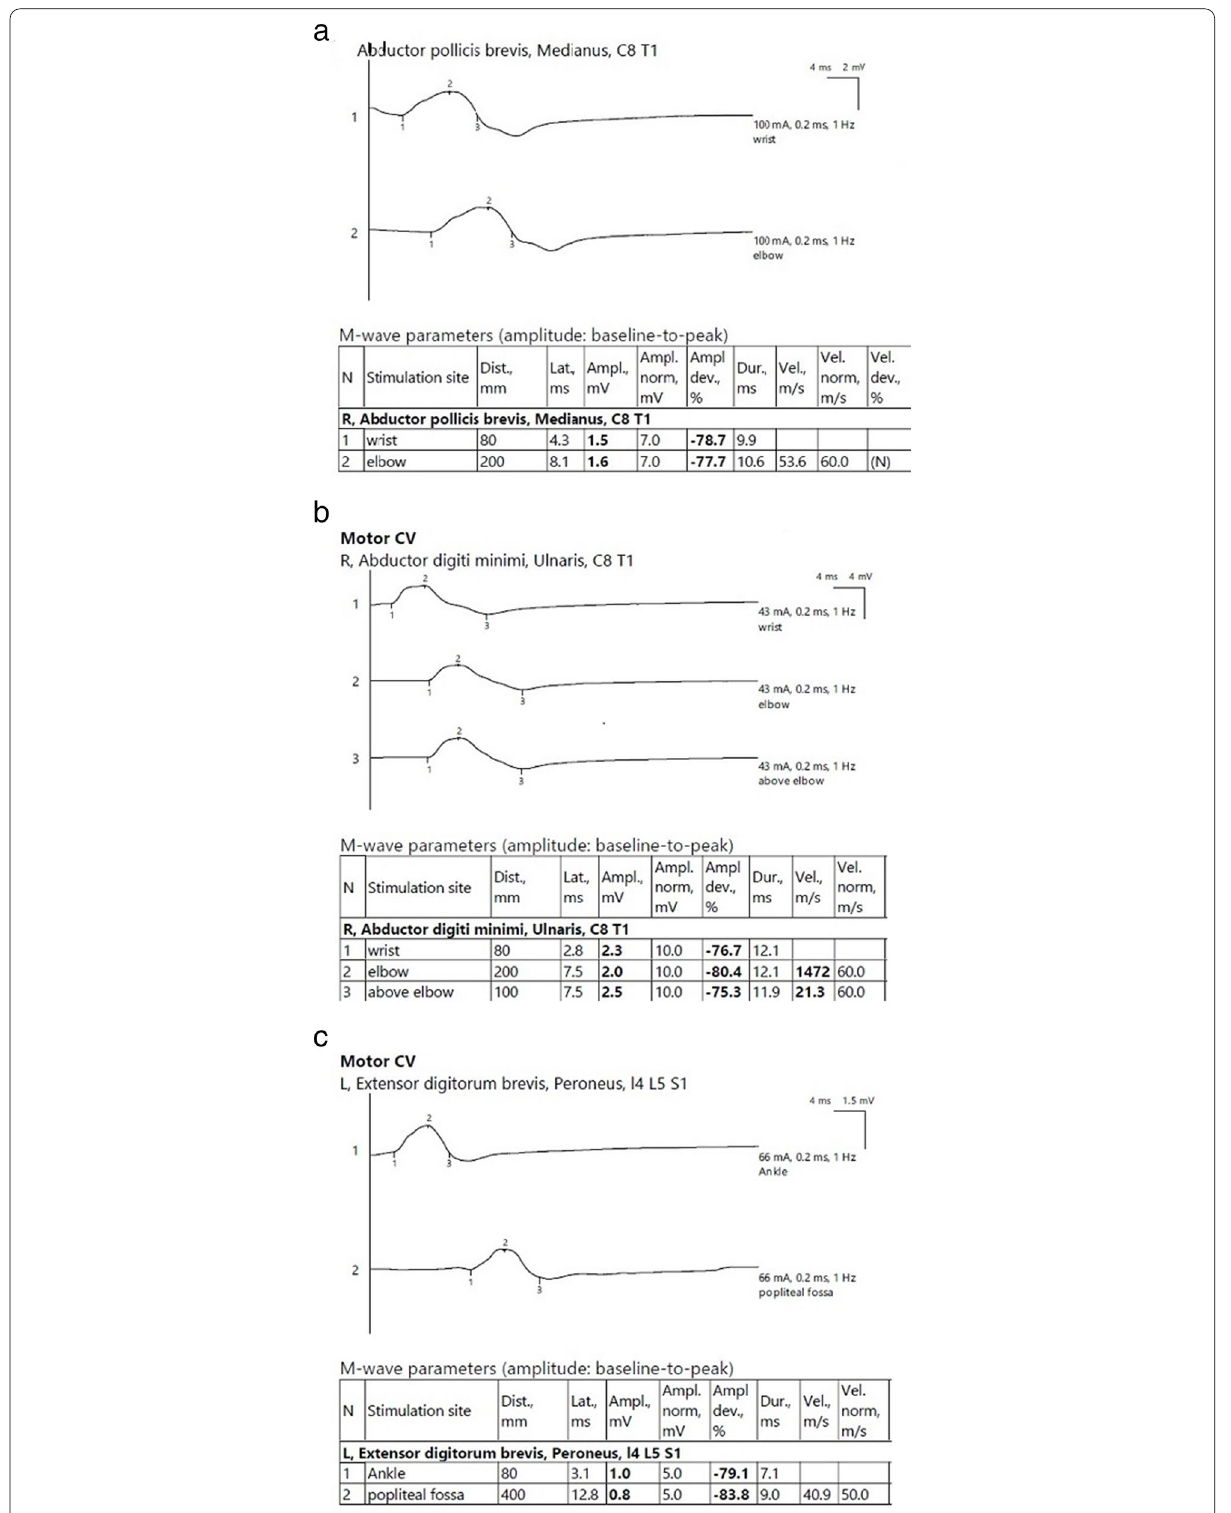
Fig. 2 a Axonal neuropathy of right median nerve at admission before starting treatment. b Axonal neuropathy of right ulnar nerve at admission before starting treatment. c Axonal neuropathy of left common peroneal nerve before